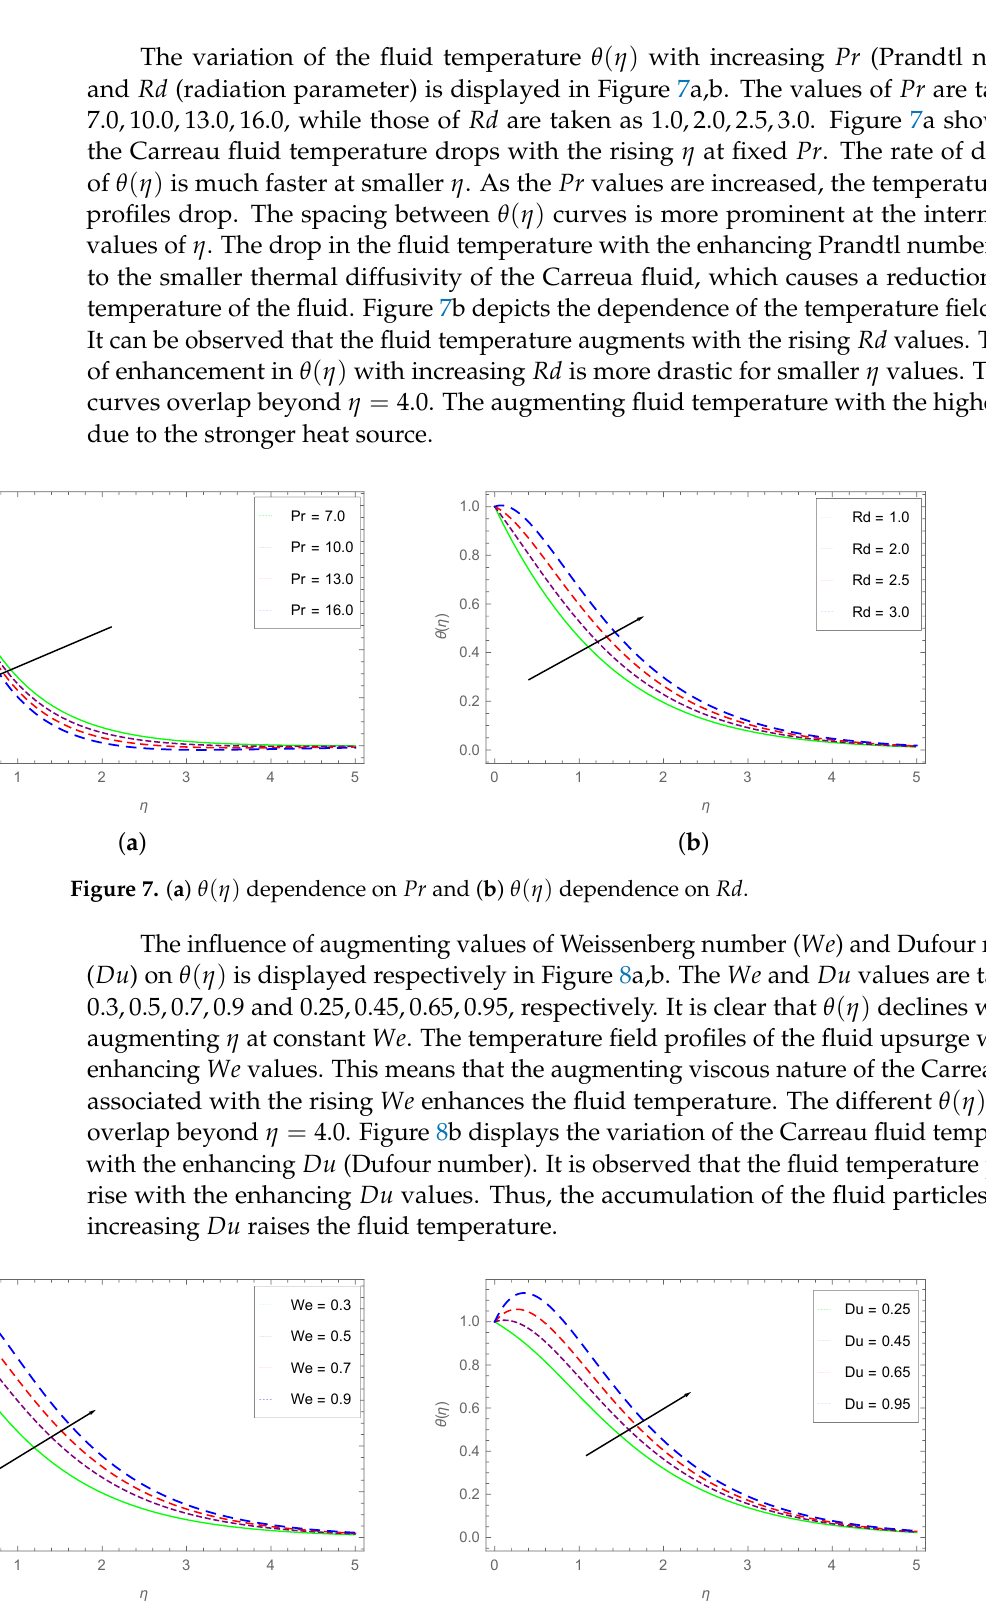
Figure 8. ( a ) θ ( η ) dependence on We and ( b ) θ ( η ) dependence on Du